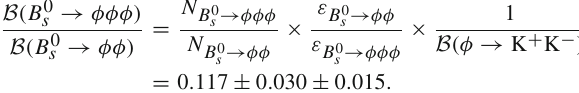
In the above expression, the event yields are determined from the fits. The efficiency ratio, ε 0 . 26 ± 0 . 01, is obtained from simulation and corrected